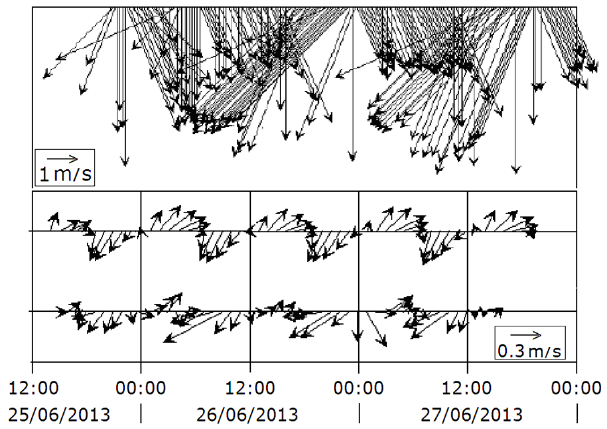
Figure 3. Lower panel: hourly averaged vectors of the current ve- locity at the depth 5m obtained at the mooring station. Middle panel: same series as simulated by POM model, see Sect. 3. Up- per panel: series of wind velocity as measured for the same